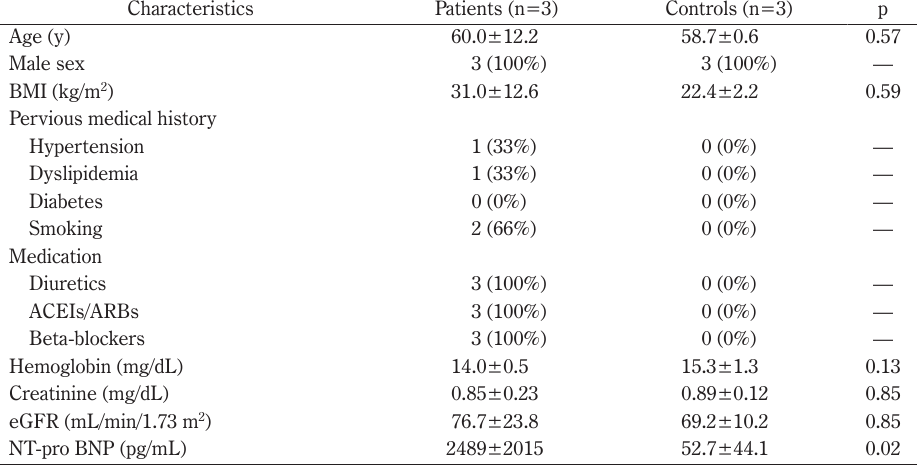
Table 1 Clinical characteristics of patients with heart failure before cardiac rehabilitation and